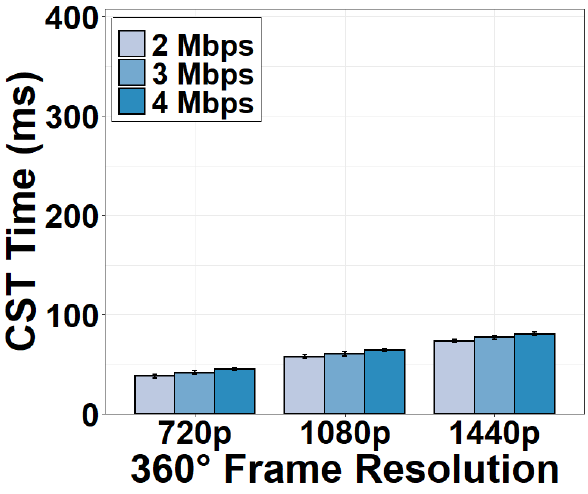
Figure 10. CST time under different encoding